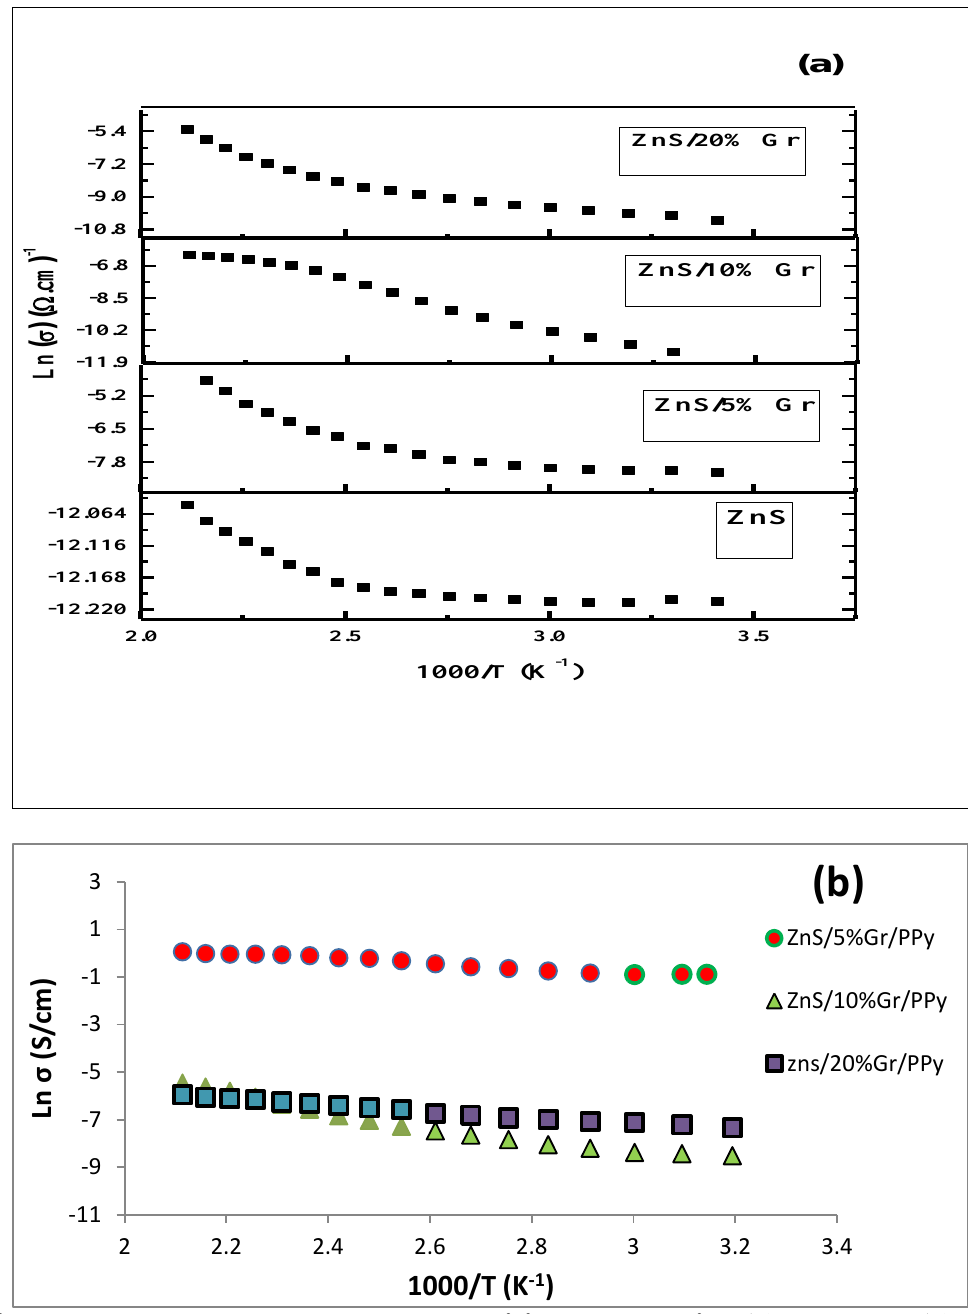
Fig.3: Temperature dependence of dc-conductivity of the deposited (a)ZnS-Gr and (b) ZnS- Gr-PPy thin